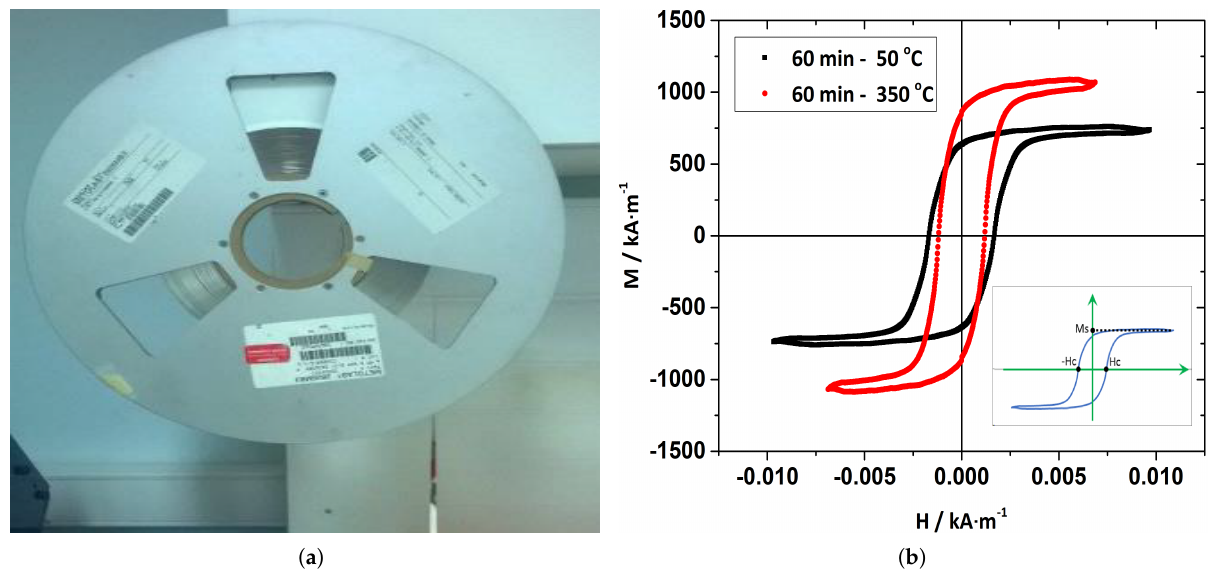
Figure 1. ( a ) Metglas 2826 MB ribbon spool. During the material production process, the spool length usually reaches hundreds of meters. ( b ) Hysteresis loop of the Metglas 2826 MB in two different temperatures. Table 1. Physical and geometrical properties of the Metglas 2826 MB ribbons. Sr.